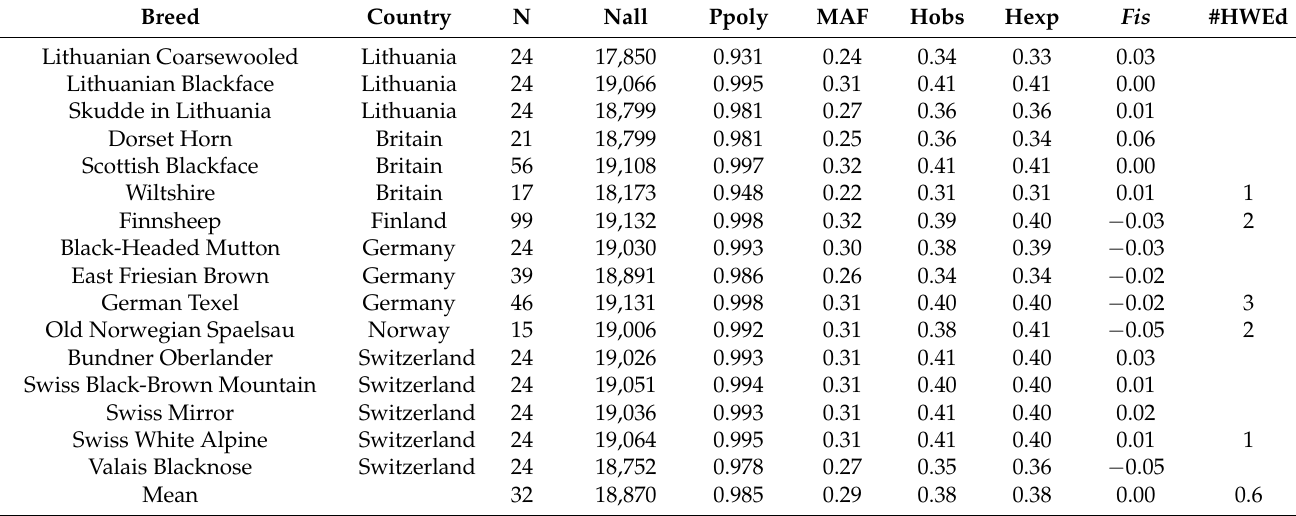
Table 1. Studied sheep populations (Breed), the country of origin for the sample (Country), sample size (N), number of observed alleles (Nall), the proportion of marker polymorphism (Ppoly), mean minor allele frequency (MAF), observed heterozygosity (Hobs), unbiased gene diversity (Hexp), inbreeding coefficient ( Fis ) and number of significant (<0.0001) Hardy–Weinberg deviations per breed based on 9583 SNP